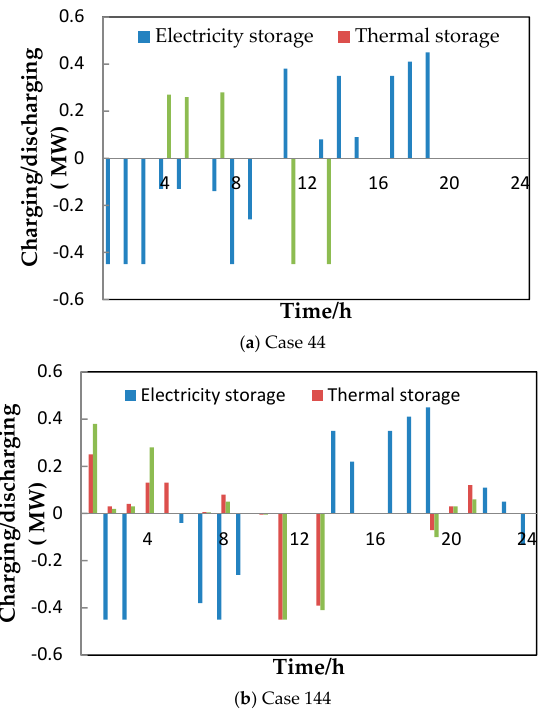
Figure 12. Charging/discharging of energy storage devices (Cases 44 and 144).